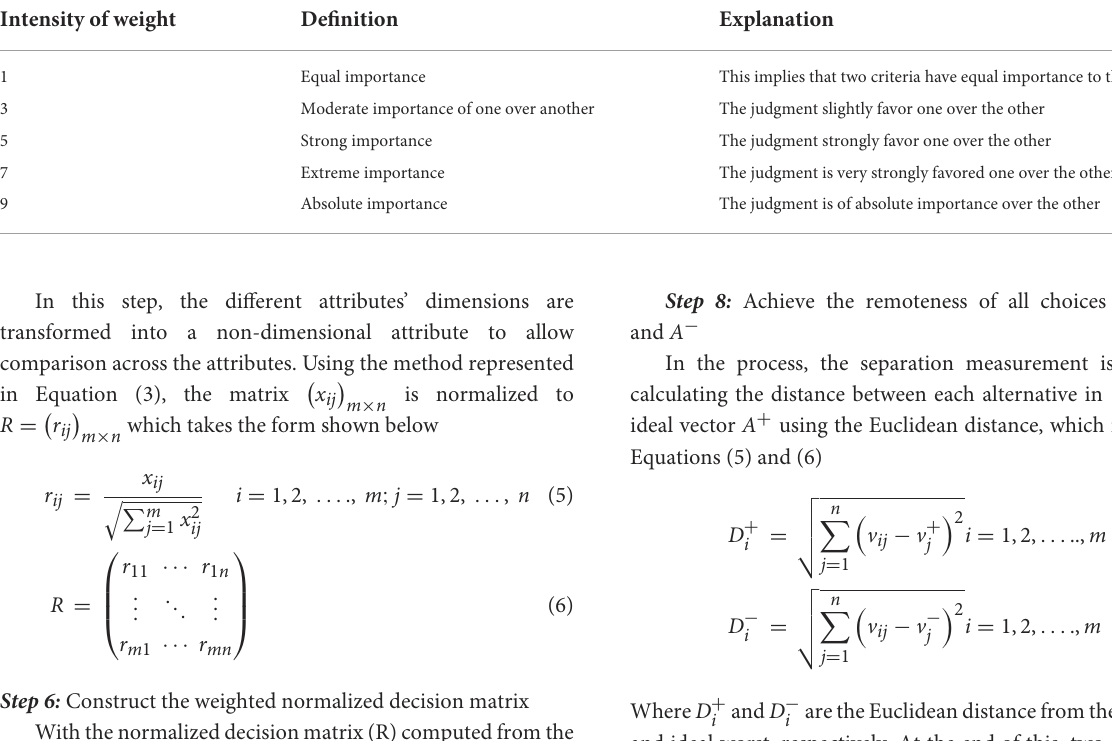
TABLE 3 Definition of the intensity of qualitative and quantitative score for criteria weight determination. Intensity of